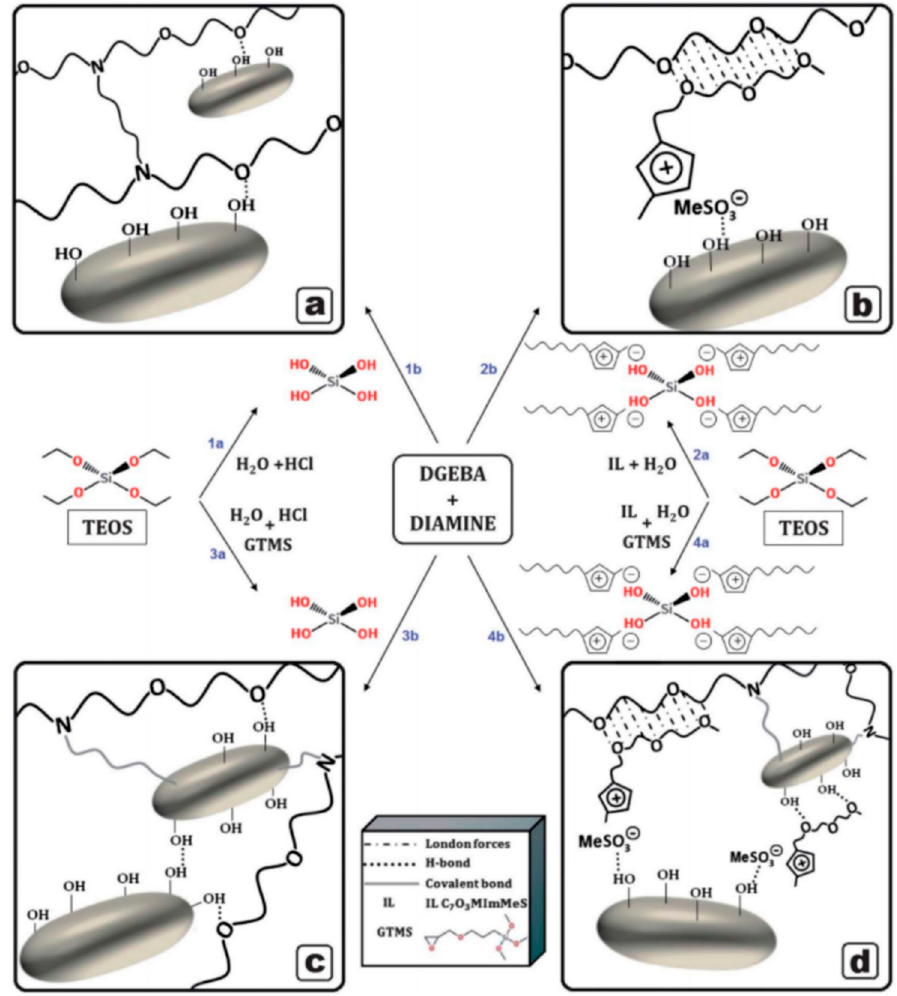
Figure 10. Schematic for various applied synthesis approaches for the preparation of epoxy–SiO 2 nanocomposites ( a ) without ionic liquid (IL) C 7 O 3 MImMeS; ( b ) with IL C 7 O 3 MImMeS; ( c ) with GPTMS; and ( d ) with GPTMS and IL C 7 O 3 MImMeS. GPTMS is labelled as GTMS in the original figure. The gray platelets represent SiO 2 nanoparticles. Reproduced with permission from Donato et al., Journal of Materials Chemistry ; published by The Royal Society of Chemistry, 2012.